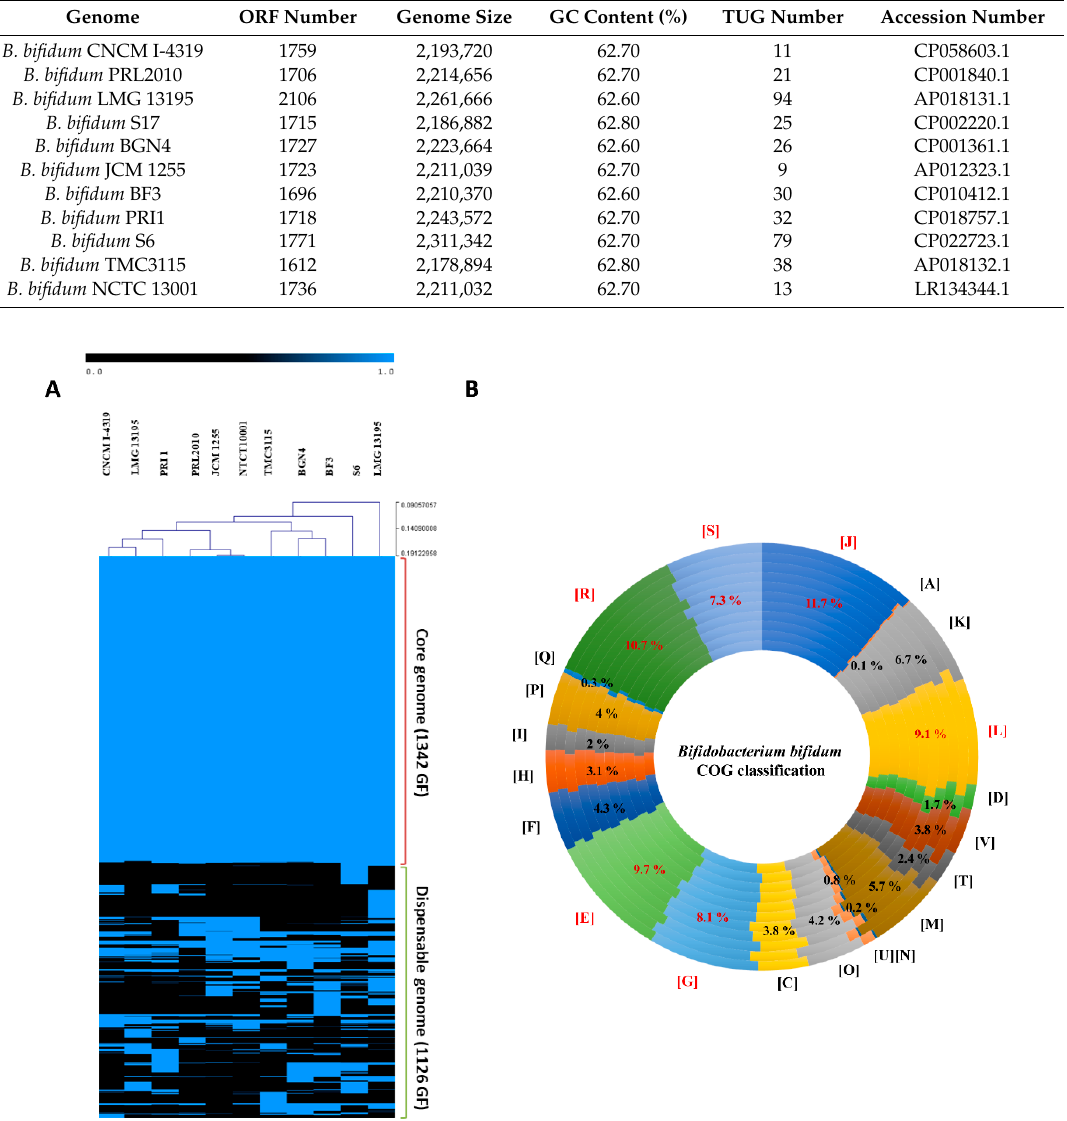
Figure 1. Comparative genomics of B. bifidum CNCM I-4319. ( A ) Hierarchical clustering heatmap representing the variability of B. bifidum in terms of presence / absence of gene families computed using all-vs.-all blastp alignment and MCL clustering. The number of core (present in all genomes) and dispensable (present in some genomes) gene families are also indicated. ( B ) Cluster of Orthologues (COG) classification of the B. bifidum families of orthologues. For each COG entry, the average percentage of hits among the species is indicated. COG classification: [D] cell cycle control, cell division, chromosome partitioning; [M] cell wall / membrane / envelope biogenesis; [N] cell motility; [O] post-translational modification, protein turnover, and chaperones; [T] signal transduction mechanisms; [U] intracellular tra ffi cking, secretion, and vesicular transport; [V] defence mechanisms; [A] RNA processing and modification; [J] translation, ribosomal structure and biogenesis; [K] transcription; [L] Replication, recombination and repair; [C] energy production and conversion; [E] amino acid transport and metabolism; [F] nucleotide transport and metabolism; [G] carbohydrate transport and metabolism; [H] Coenzyme transport and metabolism; [I] lipid transport and metabolism; [P] inorganic ion transport and metabolism; [Q] secondary metabolites biosynthesis, transport, and catabolism; [R] general function prediction only; [S] function unknown. The most abundant families are highlighted in red and they are assigned to housekeeping